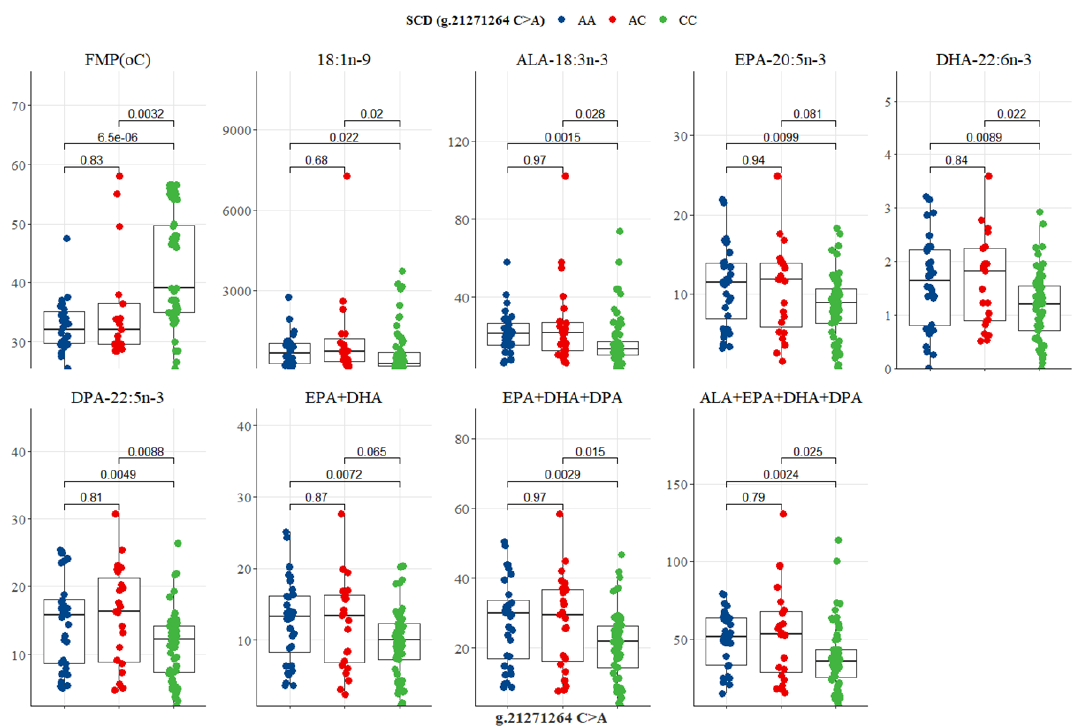
Figure 8. Tukey-adjusted multiple comparisons between an SCD SNP locus with FMP, IMF, and fatty acid profiles of Bowen Genetics Forest Pastoral Angus, Hereford, and Wagyu. Each box plot tested the mean IMF, FMP, and fatty acid in AA versus AC, AA versus CC, and AC versus CC genotypes. Significant level set at ( p < 0.05).